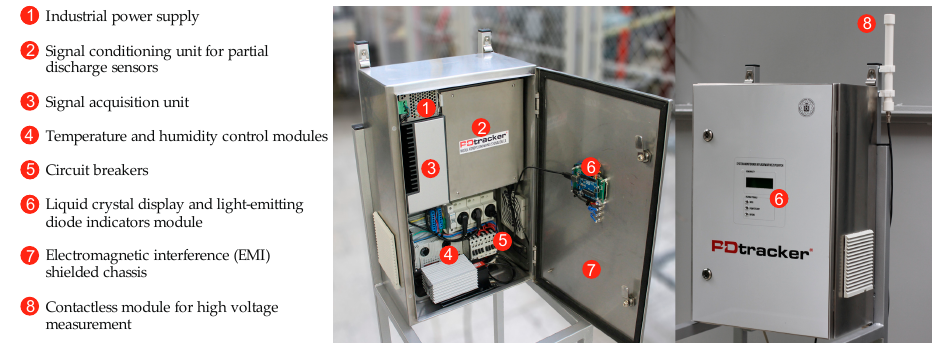
Figure 1. Hardware architecture of a prototype online partial discharge (PD) monitoring system for power transformers.